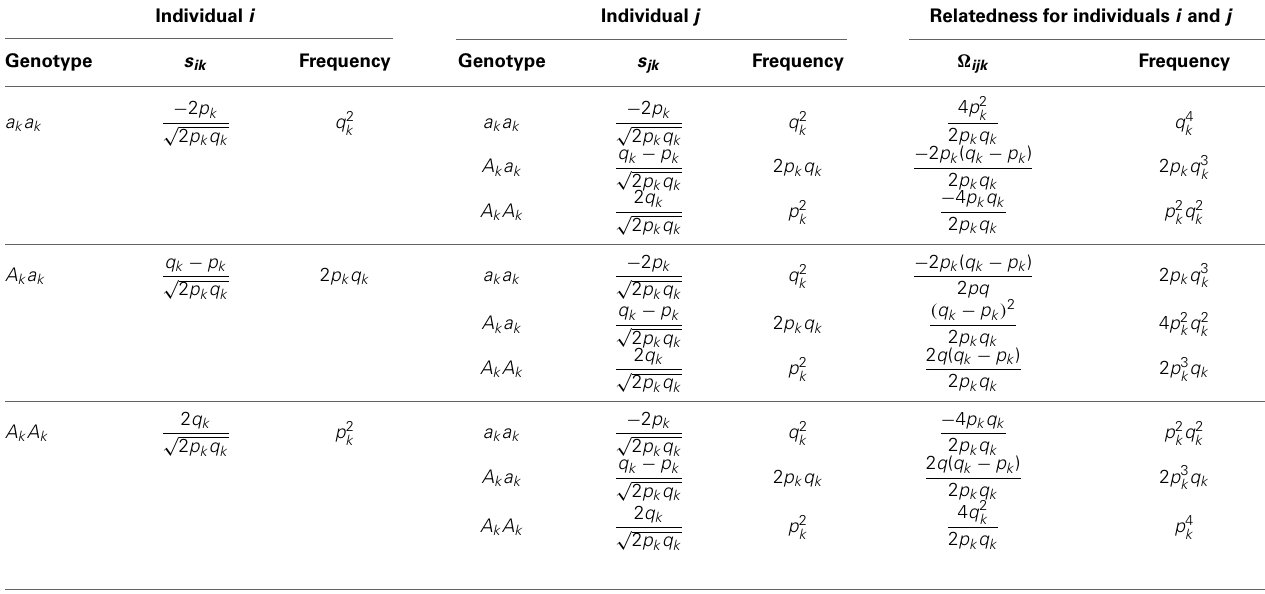
Table 3A | The joint distribution of the genetic relatedness between individuals i and j . Individual i Individual